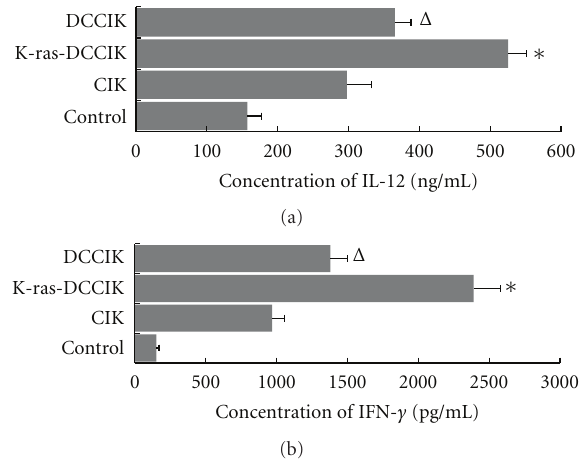
Figure 5: The production of IL-12 and IFN- γ of CIK cultured with K-ras antigen-pulsed DC (experiment 2.4). In the supernatant of group K-ras-DCCIK cultured for 14 days, IFN- γ and IL-12 levels were highest, K-ras-DCCIK versus DCCIK and CIK ( ∗ P < 0 . 01). And levels in group DCCIK were also higher than those of CIK ( Δ P < 0 . 05). It is demonstrated that after coculture of CIKs and k-ras-DCs, IFN- γ and IL-12 levels in the cell supernatants can be apparently